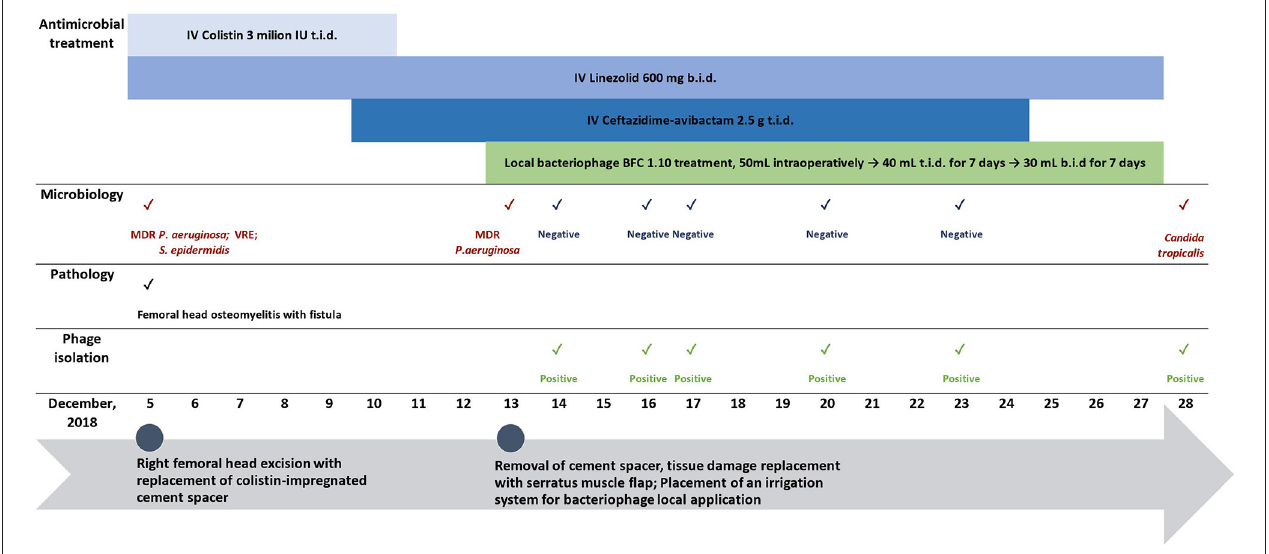
FIGURE 3 | Biofilm formation of isolated P. aeruginosa from the patient and two reference strains (ATCC 14209, ATCC 2785) over 48-h. Sterile trypticase soya broth was used as a negative